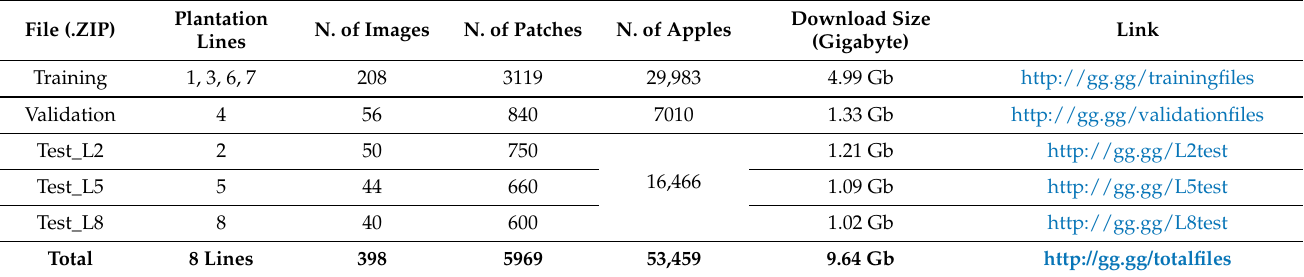
Table A1. Table with the size of the files to